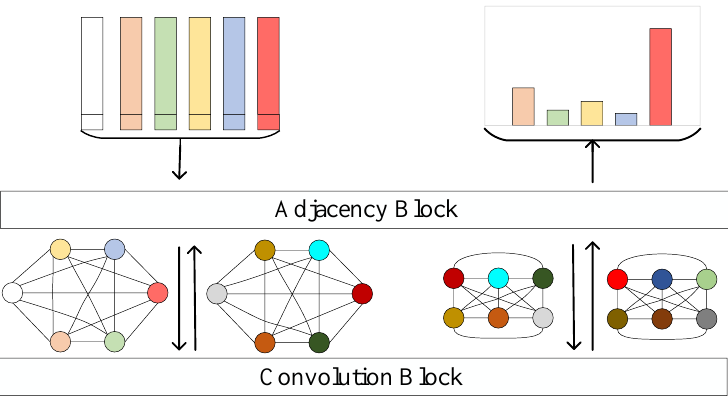
Figure 4. The training process of the graph neural network. Perform each Convolution Block after Adjacency Block.